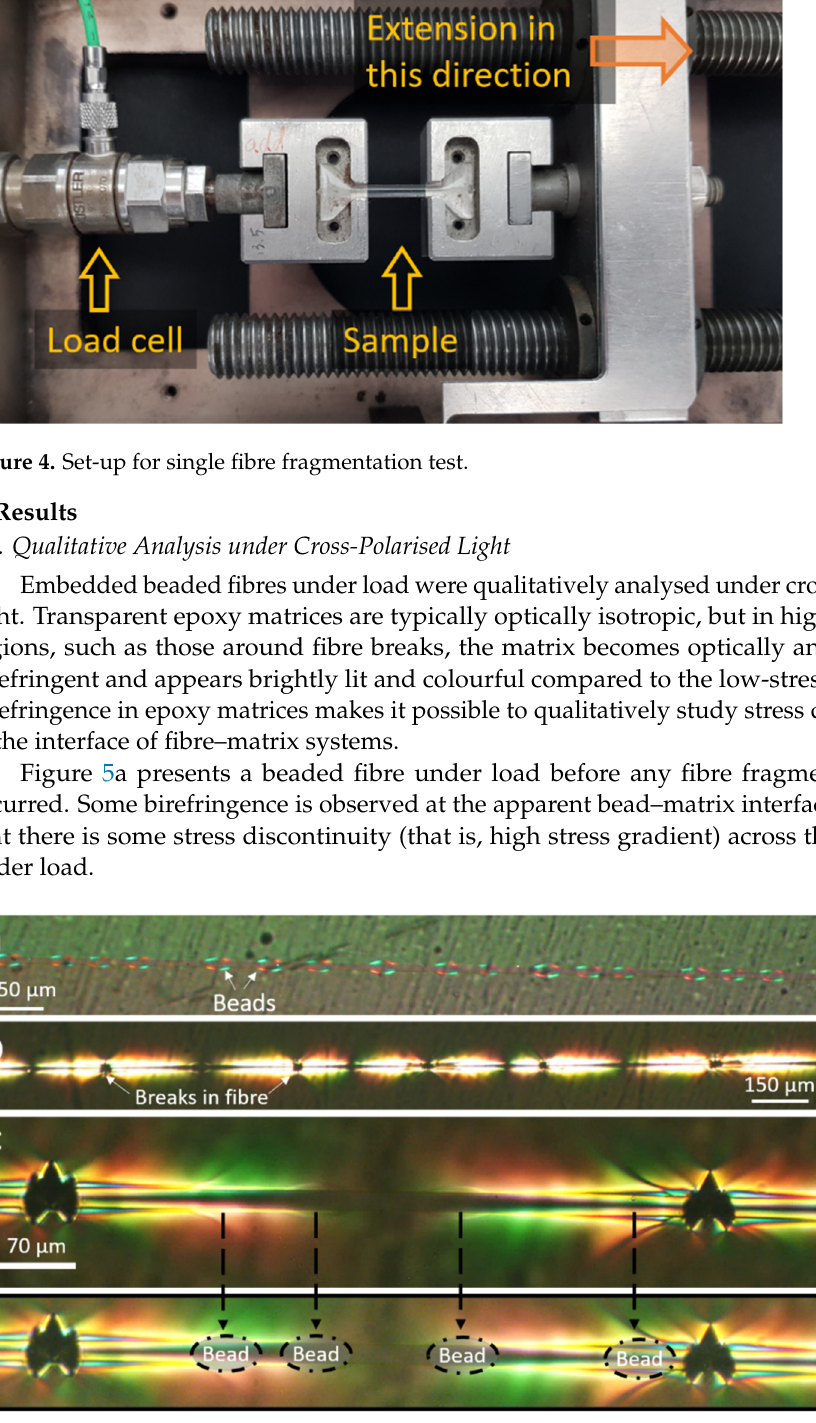
Figure 5. Fragmentation behaviour of beaded fibres under load under cross-polarised light. ( a ) Beaded fibre embedded in epoxy under load. ( b ) Birefringence pattern of a beaded fibre after fragmentation saturation. The black dots indicate fibre breaks. ( c ) Beaded fibre fragment between fibre breaks with bead positions outlined in dotted lines below.